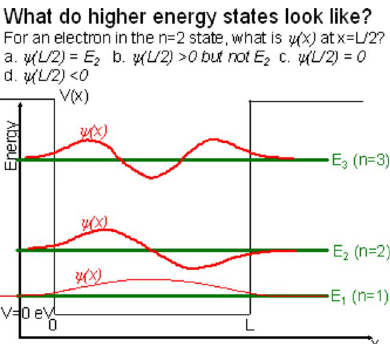
FIG. 3. (cid:1) Color (cid:2) A concept question designed to elicit student confusion between energy and wave function. The correct answer is C but students who do not understand the meaning of superimpos- ing a wave-function graph on an energy graph may be inclined to answer A. When we ask this question in class, it generates a large amount of discussion. While most students (cid:1) 73%–88%, depending on the semester (cid:2) eventually answer the question correctly, listening in on student discussions reveals that most do not know the answer right away and only figure it out through vigorous debate with their neighbors. Even after discussion, 9%–19% give answer A.